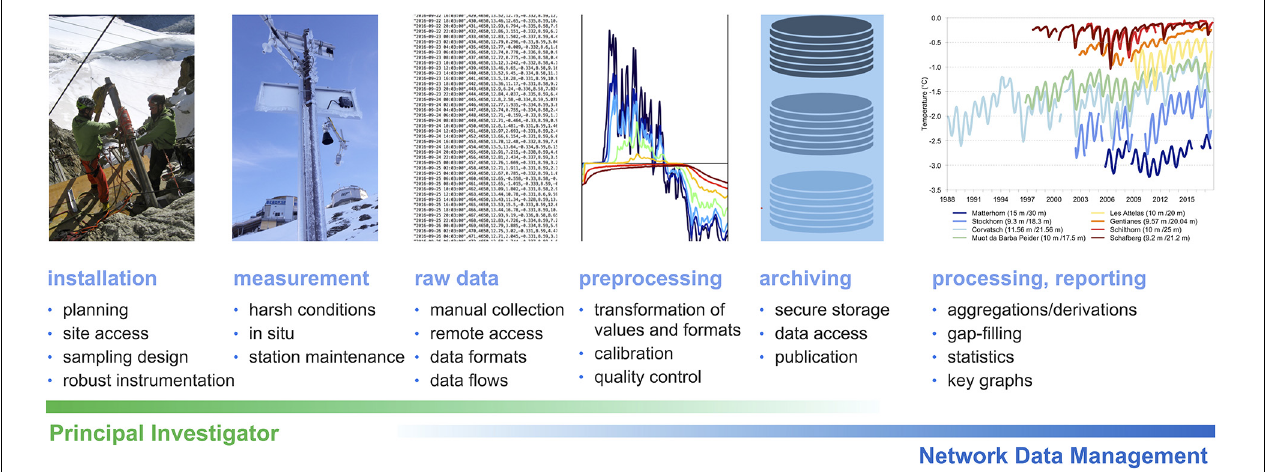
FIGURE 3 | Procedure to obtain permafrost temperatures measured in a borehole: from planning and installation of the measurement infrastructure (far left), operation and measurement, data collection, quality control, archiving, to processing and publication (far right). In this paper, we address the first three tasks, which are typically the responsibility of a research institution/principal investigator. Data source and photos: PERMOS.